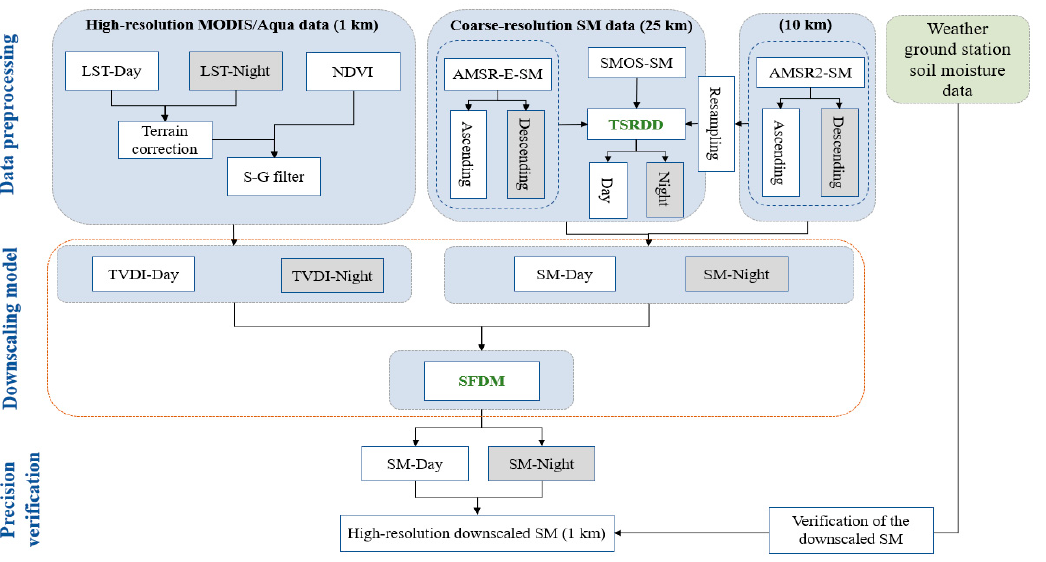
Figure 2. Flow chart of the downscaling process.